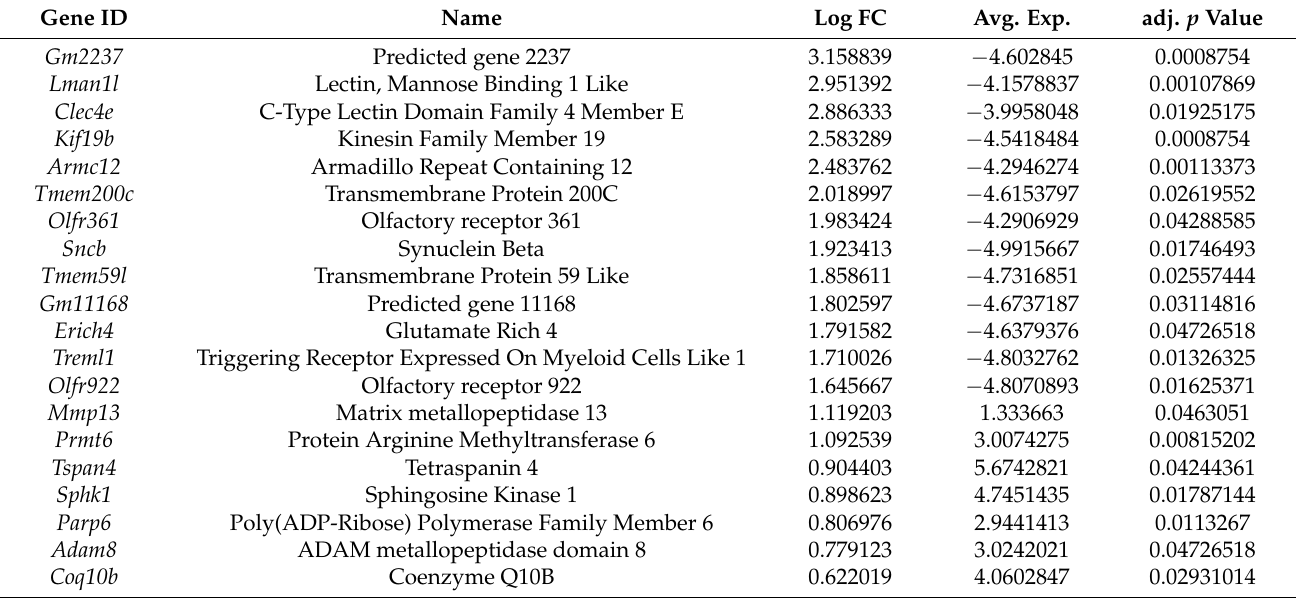
Table 2. Top 20 upregulated genes in BSp-treated breast tumor samples vs. control tumor samples. For both groups n = 7 mice and significance cutoff was an adjusted p value <